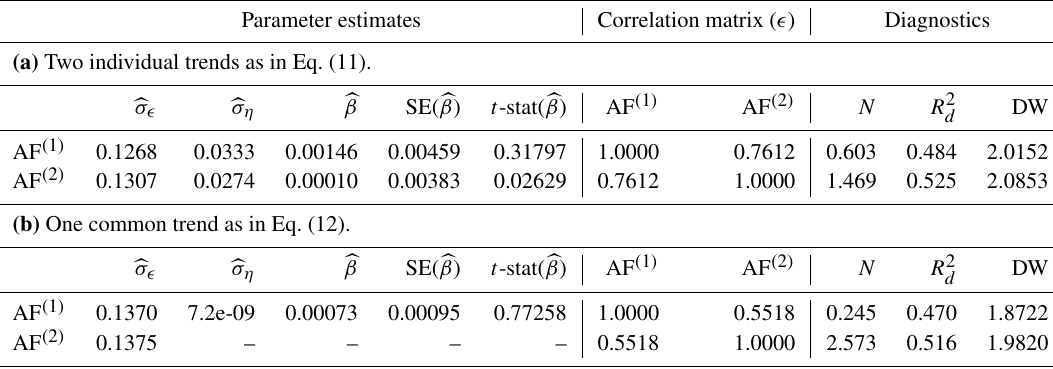
Table 2. Multivariate analysis of the airborne fraction.